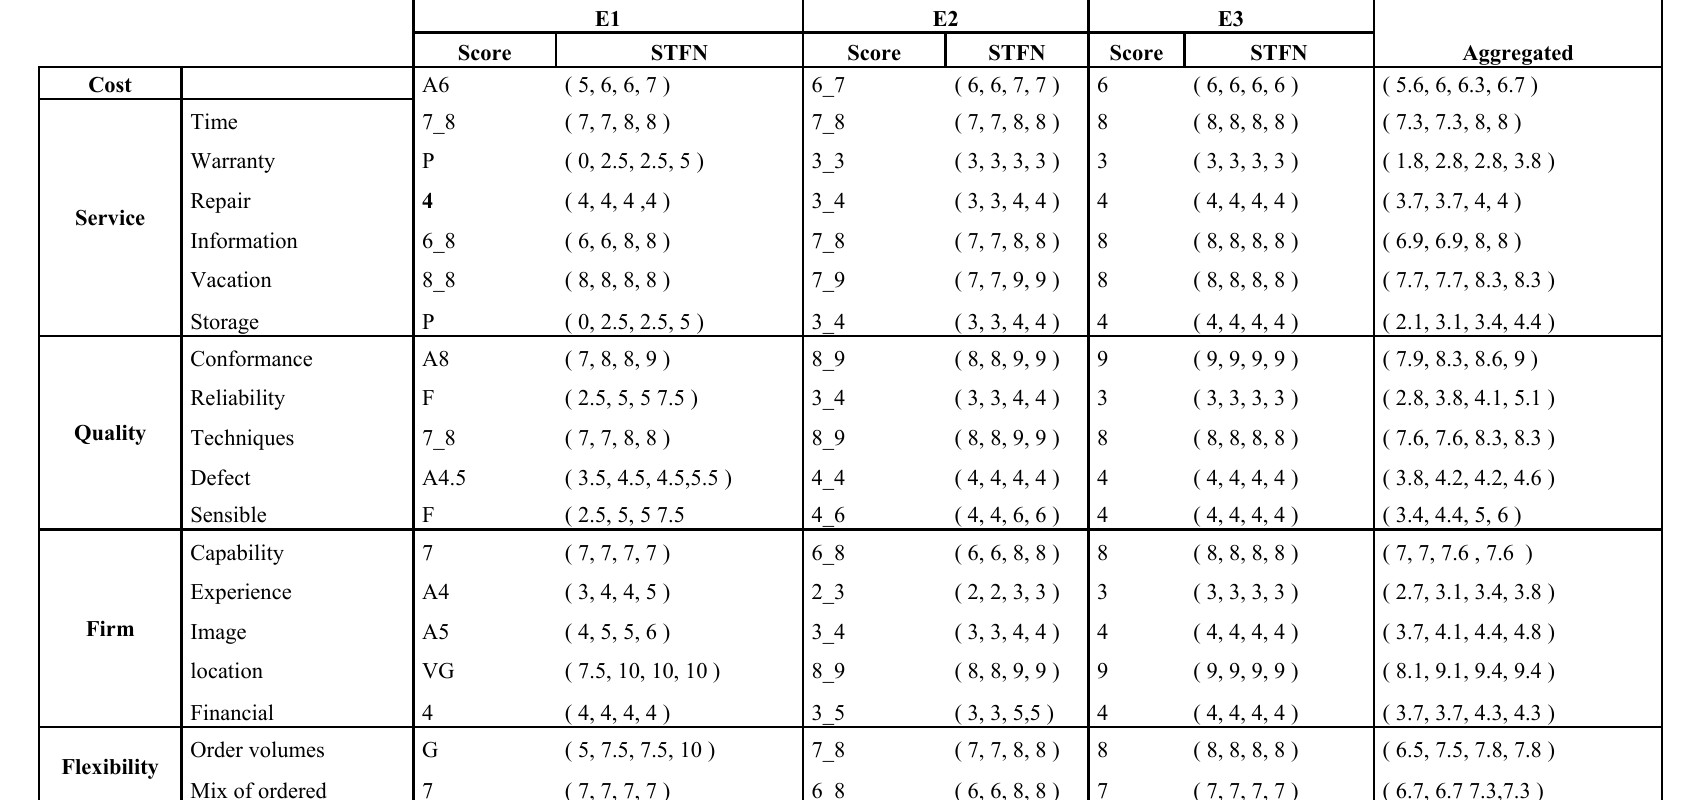
Table 2 Scores and converted STFN supplier selection criteria for supplier